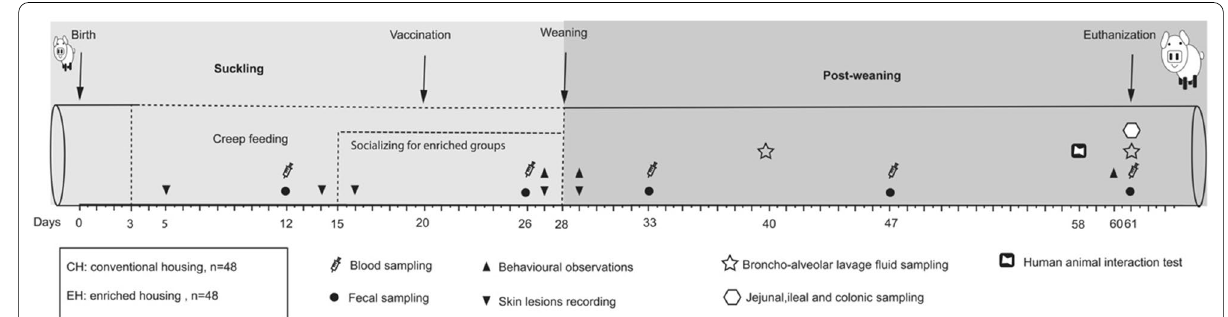
Fig. 1 Experimental set‑up. Pigs were housed in either conventional (CH) or enriched (EH) condition from birth till the end of the experiment period (day 61). Behavioural observations, human animal interaction test and skin lesion scores were assessed as a proxy for stress. Blood and broncho‑alveolar lavage fluid were collected to measure leukocytes. In addition, blood samples were evaluated for cell blood count and re‑stimulated with mitogens. Faeces and luminal digesta were collected and processed for 16S rRNA gene